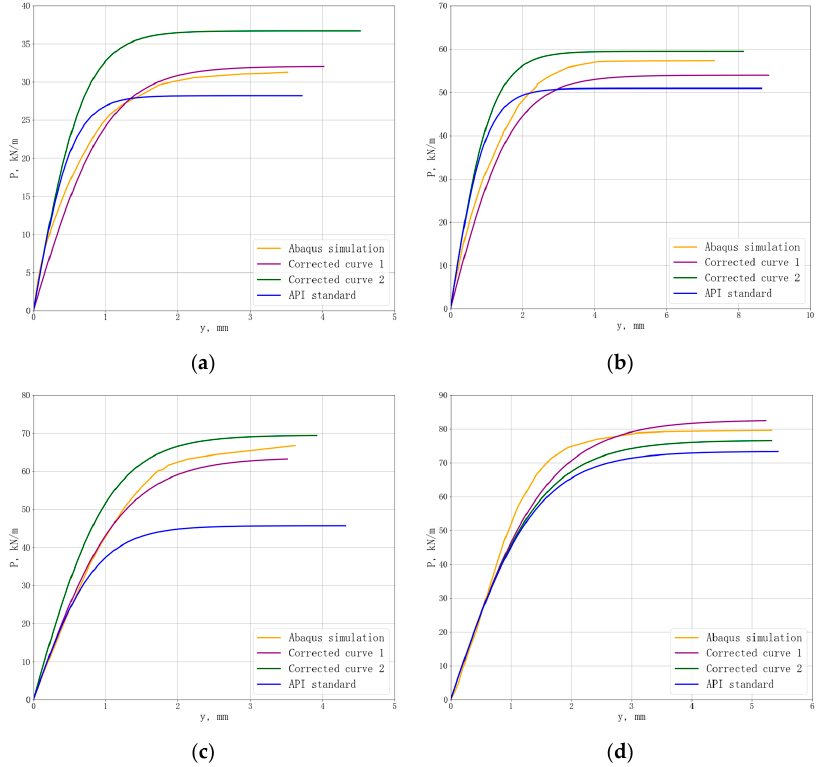
Figure 9. P-y curves of shallow seabed hydrate-bearing layers with different hydrate saturations. ( a ) P-y curve with 0% saturation. ( b ) P-y curve with 15% saturation. ( c ) P-y curve with 25% saturation. ( d ) P-y curve with 35% saturation.